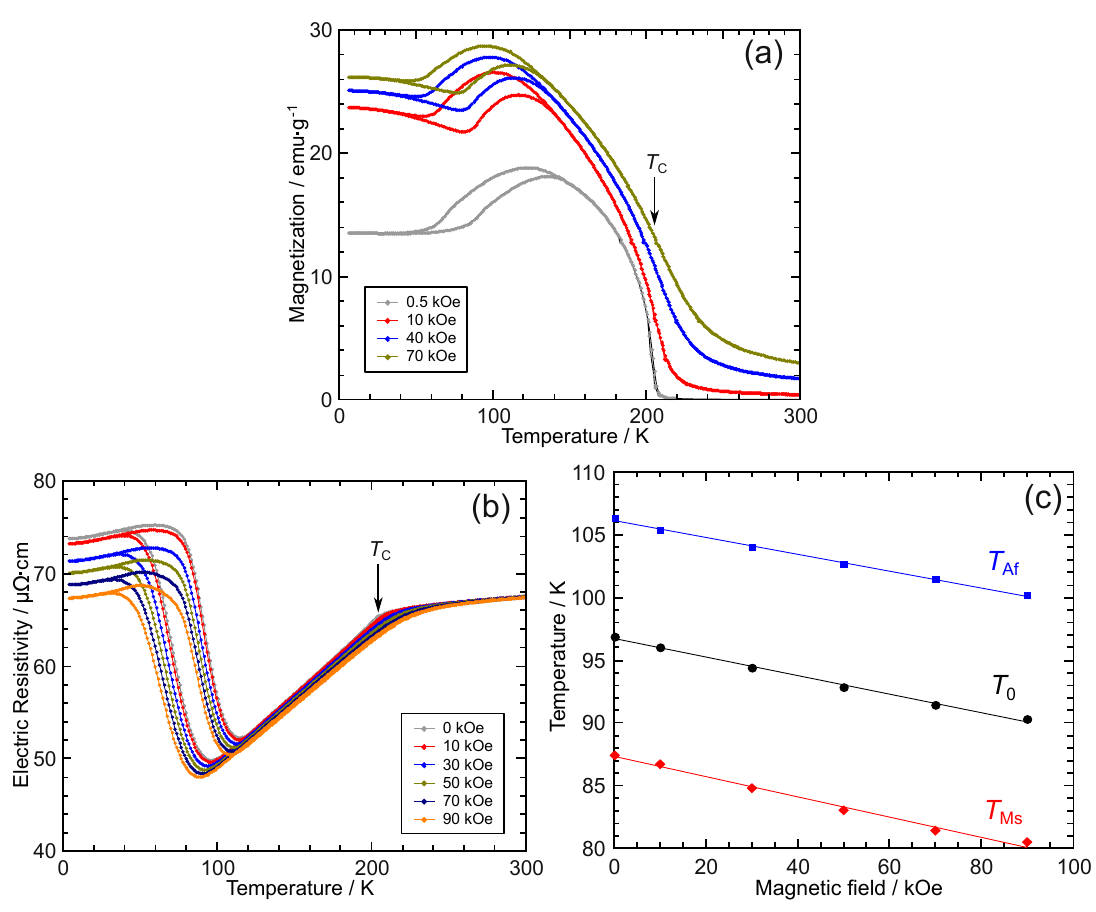
( a ) Temperature dependence of the magnetization under magnetic fields of 0.5, 10, 40, and 70 kOe. ( b ) Temperature dependence of the electric resistivity under magnetic fields of 10, 30, 50, 70, and 90 kOe. ( c ) The martensitic transformation starting temperature, T M , reverse martensitic transformation finishing temperature, T A s + T ) /2 determined from ( b ) are plotted against the magnetic field. Solid lines supposed as T 0 = ( T M A f s are least-square linear